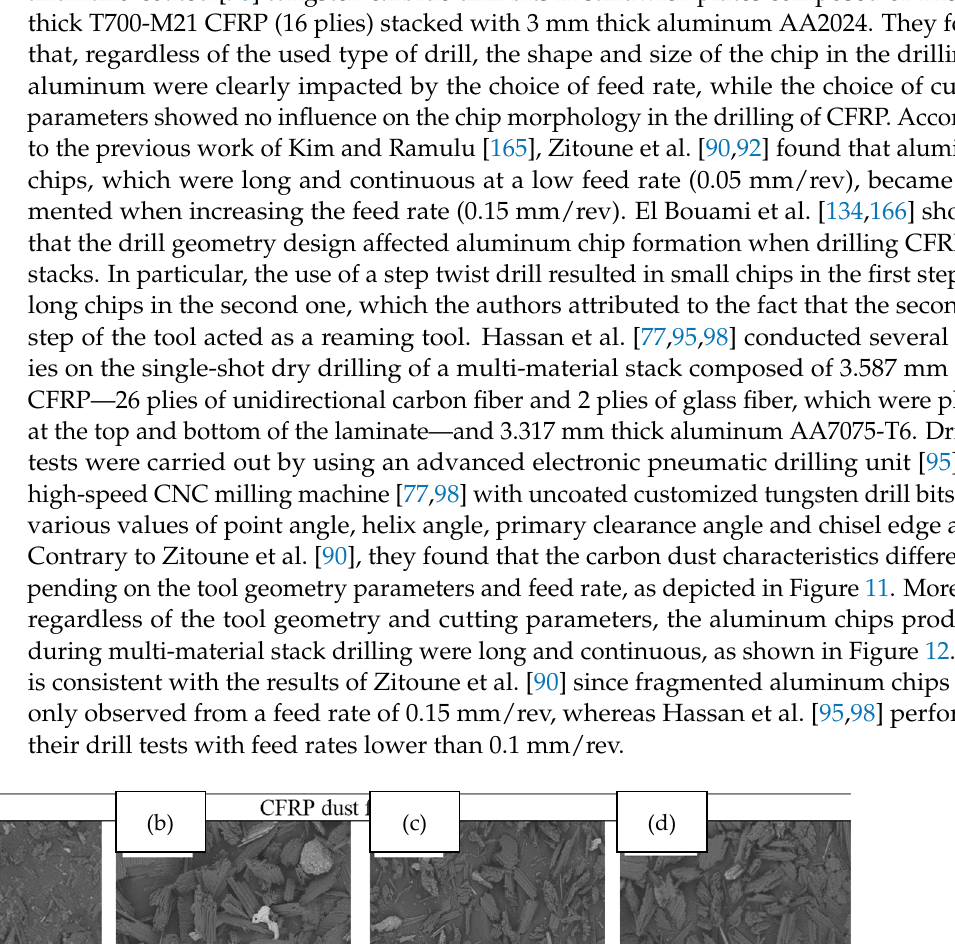
Figure 12. Chip characteristics of AA7075-T6 depending on tool geometry parameters and cutting parameters: ( a – d ) Point angle of 110°, ( e – h ) Point angle of 130° [95]. Sridhar et al. [128] and Bolar et al. [102] observed the same tendencies concerning the evolution of the aluminum chip morphology with the feed rate when drilling CARALL FML, composed of carbon fiber prepreg and AA2024 aluminum layers stacked alternately, using a 6.8 mm diameter solid carbide two-fluted drill with a 140° point angle. However, spindle speed was also found to influence the chip breakability, although its impact was considerably lower than that of the feed rate.